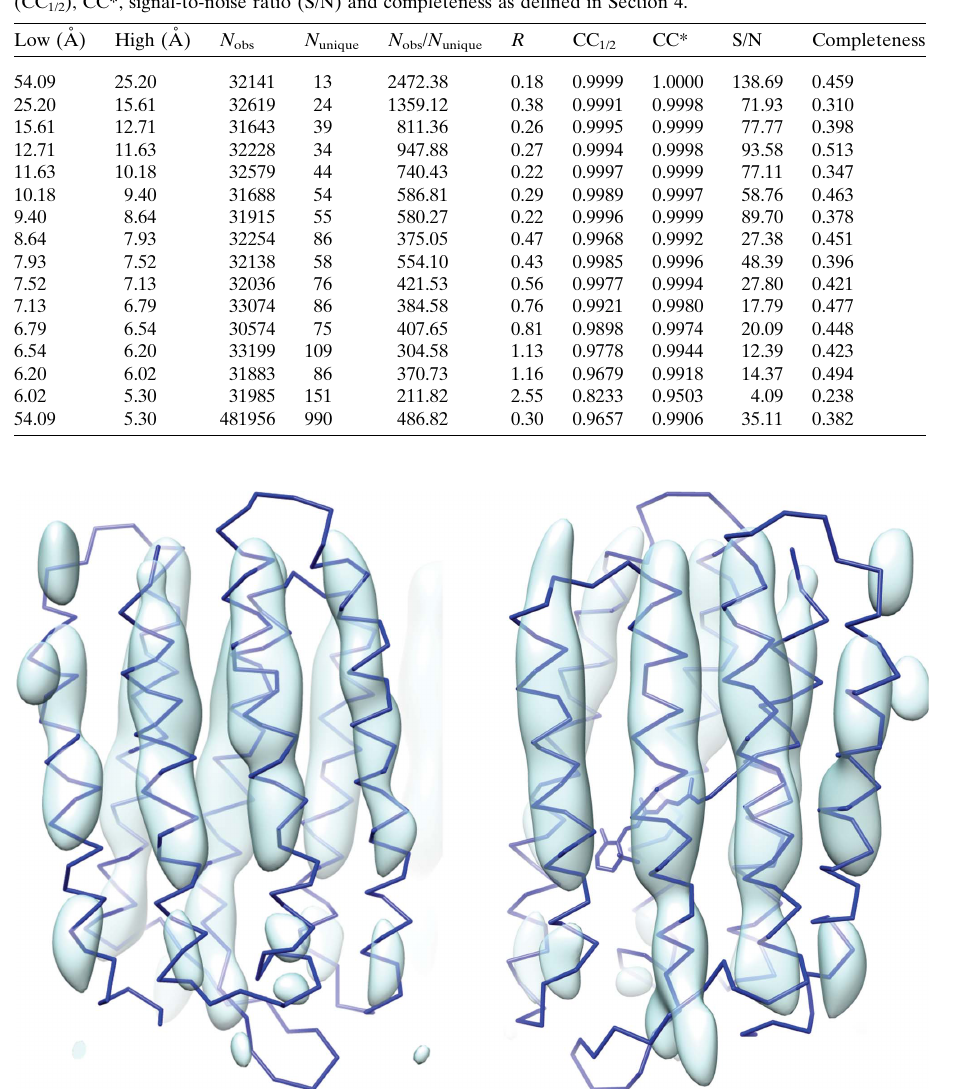
Figure 4 Composite OMIT map. Blue trace, backbone of atomic model 1fbb rigid-body refined using the experimental data with sampling (cid:6) q rod = (1/2)( (cid:4) / d ). Cyan surface, the composite OMIT electron-density map with a contour level of 3.0 (cid:8) . The structure is shown from two different